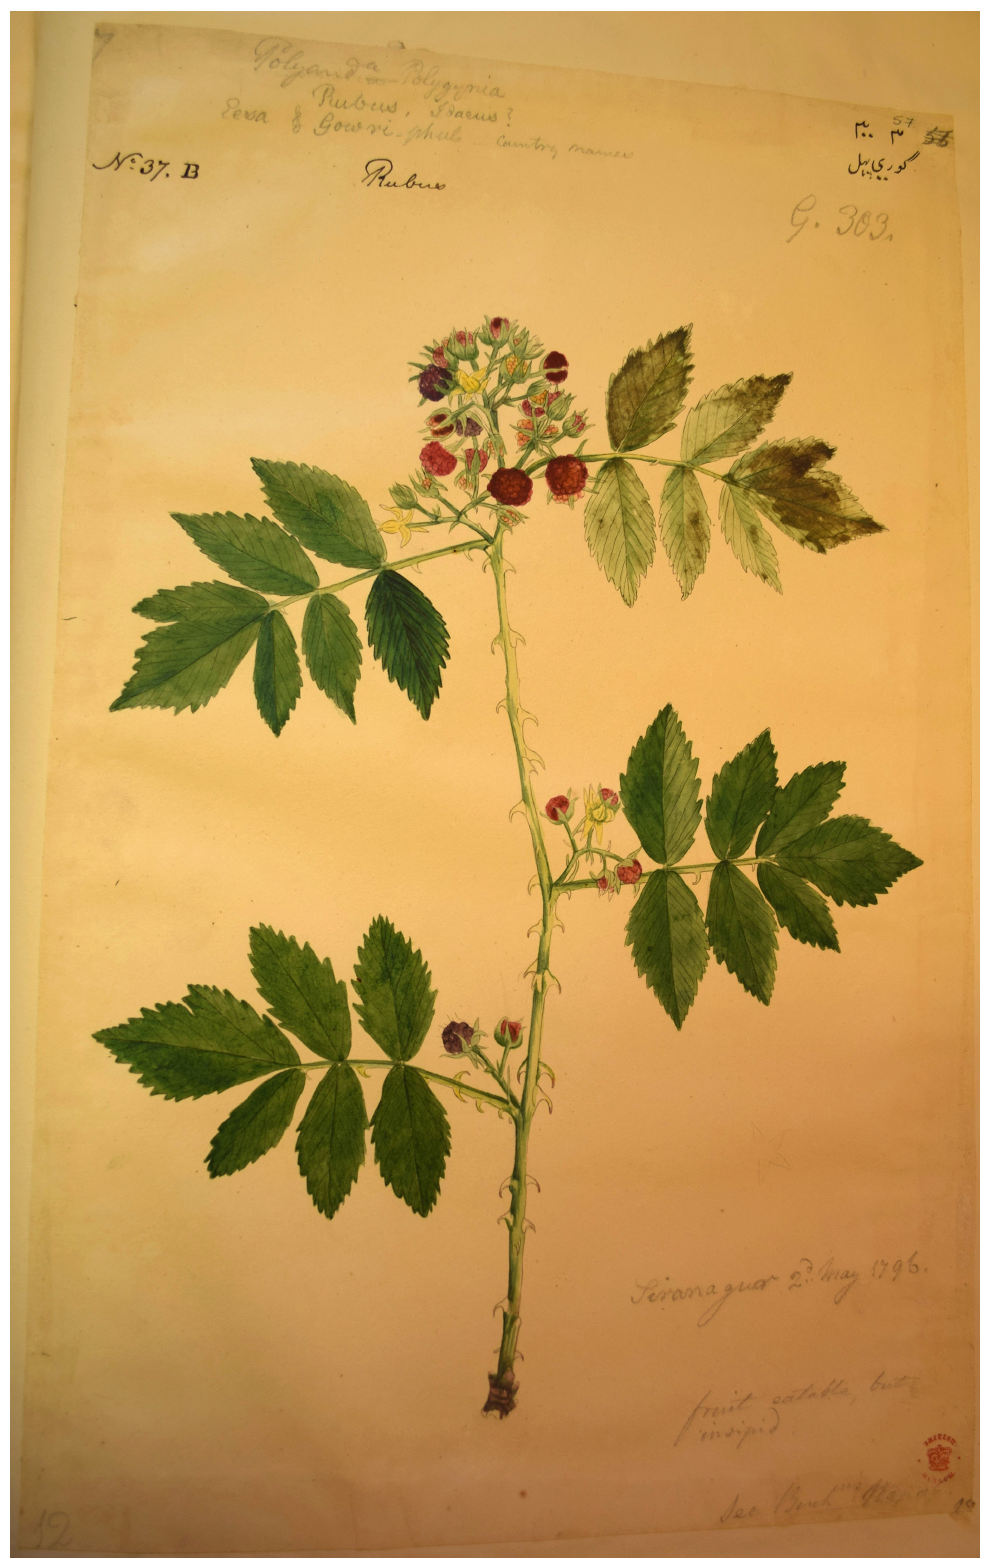
Fig. 9. Lectotype of Rubus rosiflorus Roxb., Hardwicke, Plants of India Vol. X (Add MS 11019): drawing no. 58. Reproduced with permission of the British Library